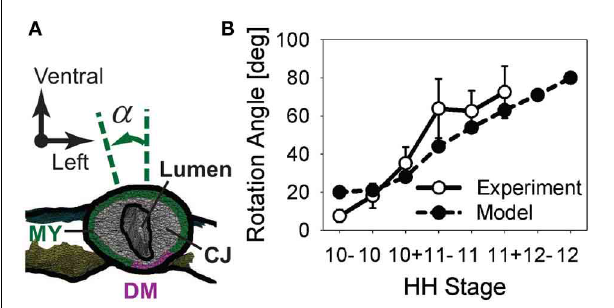
FIGURE 5 | Rotation of heart tube during c-looping. (A) Rotation angle α is defined as the angle between the long axis of the elliptical lumen and the embryonic dorsal-ventral axis in a cross section located at the middle of the heart tube (CJ, cardiac jelly; DM, dorsal mesocardium; MY, myocardium). (B) Plot of rotation angle given by baseline model and experimental measurements as function of developmental stage.